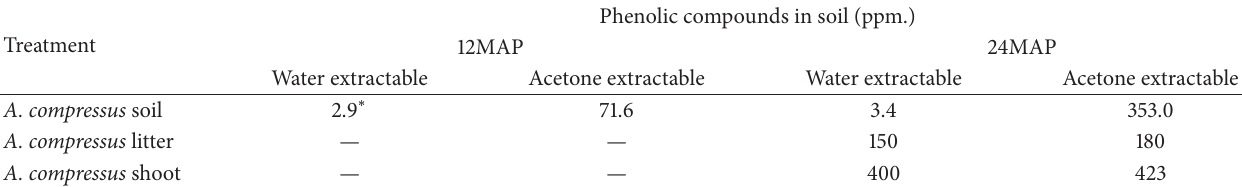
Table 1: Water and acetone extractable phenolics in A. compressus tissues and soil at different sampling